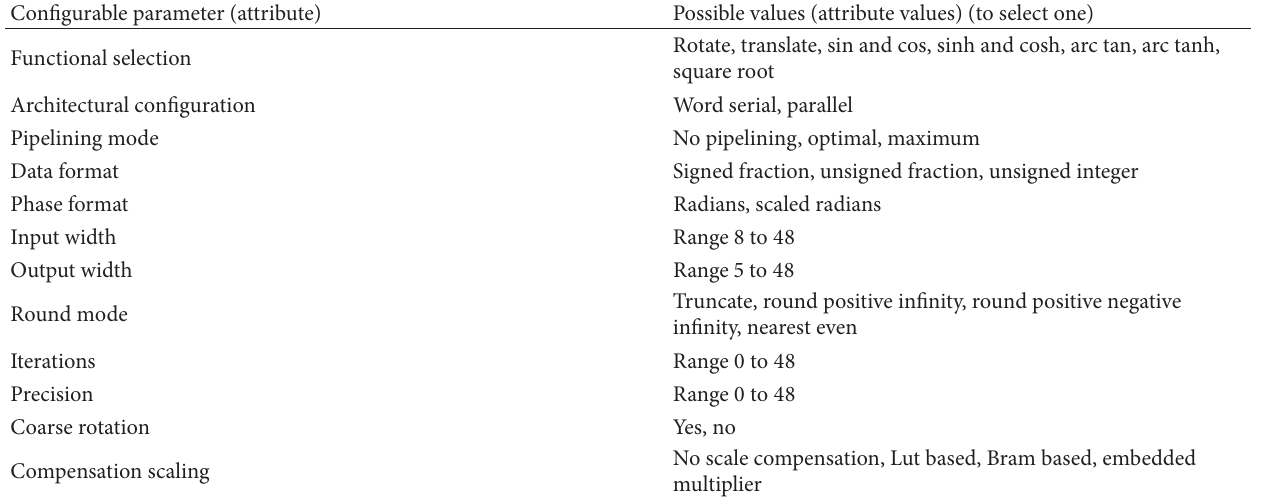
Table 11: Configurable parameters in Xilinx CORDIC IP